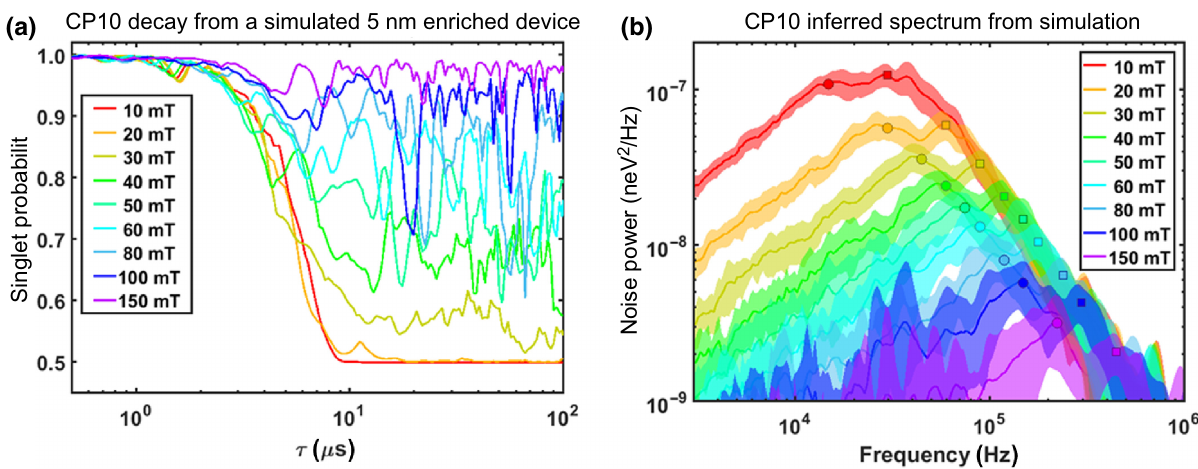
FIG. 9. (a) Simulated decay of a CP10 experiment versus magnetic field under the effects of 73 Ge quadrupolar dynamics only, for a single simulated device with a 5-nm-wide, isotopically enriched Si well. Nuclear dipole-dipole dynamics are not included in this simulation. (b) Inferred magnetic noise spectrum, via Eq. (7), from an ensemble of 20 time-domain simulations such as that in (a), each using a different random configuration of 73 Ge nuclei. The lines show the average spectrum across the ensemble, and the bands the standard deviation. The circle on each trace shows the location of the 73 Ge Larmor peak and the square its first